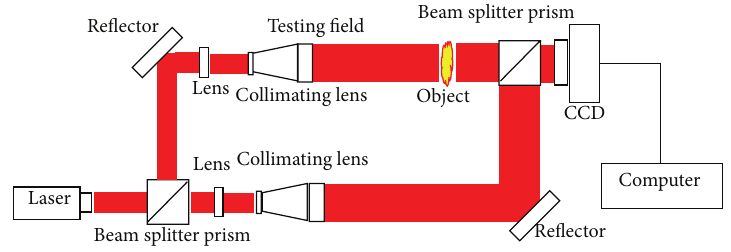
Figure 1: Off-line recording of digital hologram.